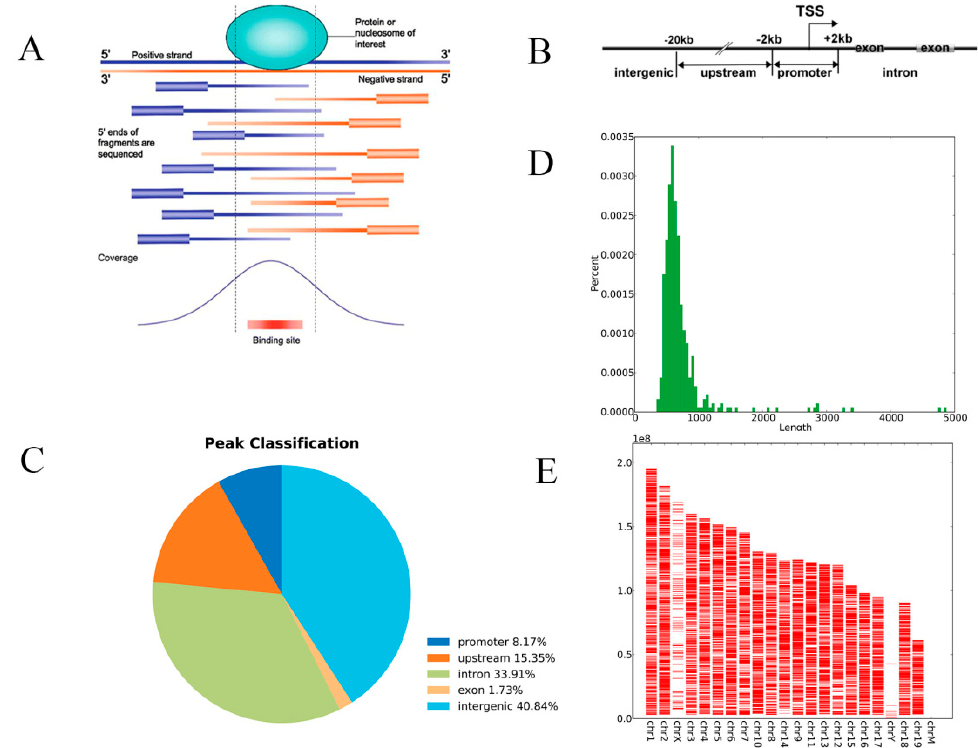
Figure 1. The results of chromatin immunoprecipitation sequencing (ChIP-Seq). Two samples from the low benzene (LB) group and two samples from the control group were selected. ( A ) Enriched peak. ( B ) Peak annotation. The enriched peaks were identified and classified as follows: Promoter peaks, upstream peaks, intron peaks, exon peaks, and intergenic peaks. ( C ) Peaks classification. Of the total generated significant peaks in the control sample ( p < 0.0001), 8.17% were within the promoter region, 33.9% were within introns, and 40.84% were within the intergenic region. ( D ) Peak length distribution. The length distribution of the enrichment peak is calculated to infer the length of the DNA binding region. ( E ) ChIP-Seq peaks over chromosomes. The distribution of peaks in the genome was statistically enriched, and the chromosomes in the DNA binding region were viewed as a whole. Table 3. Sequencing reads statistics of the ChIP experiment.